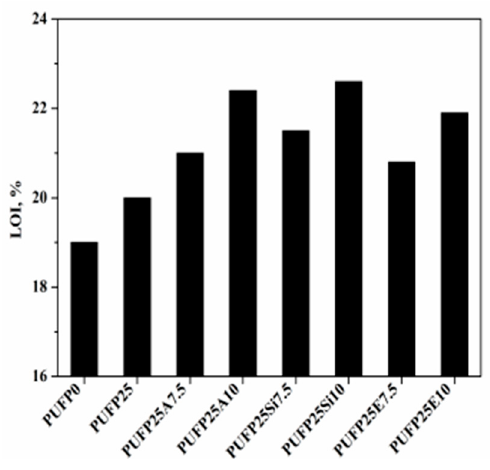
Figure 8. LOI value of RPUF.